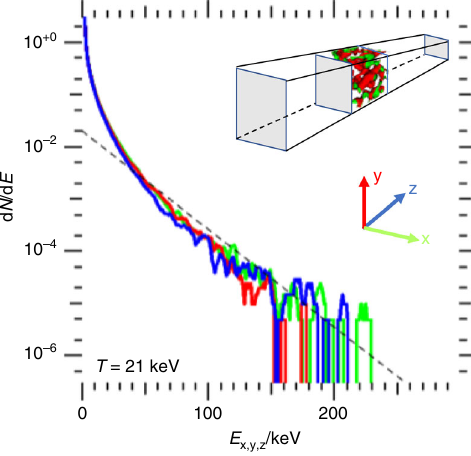
Fig. 4 Isotropy of CD nanofoam explosions. Directional ion energy spectra in 3D particle-in-cell simulation, labeled by direction. Laser propagates along z -axis and is polarized along y -axis. Directional ion “ temperatures ” ffiffiffi p are reduced by a factor 3 compared to the total; compare Fig. 3. (Dashed line represents an effective temperature for this distribution of 21